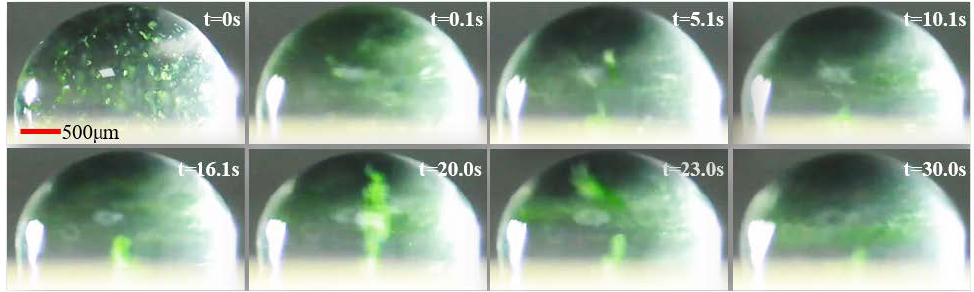
Figure 4. The photographs of the 9 µm PS particles driven by SAWs to form acoustic swirls in 8 µL droplet.